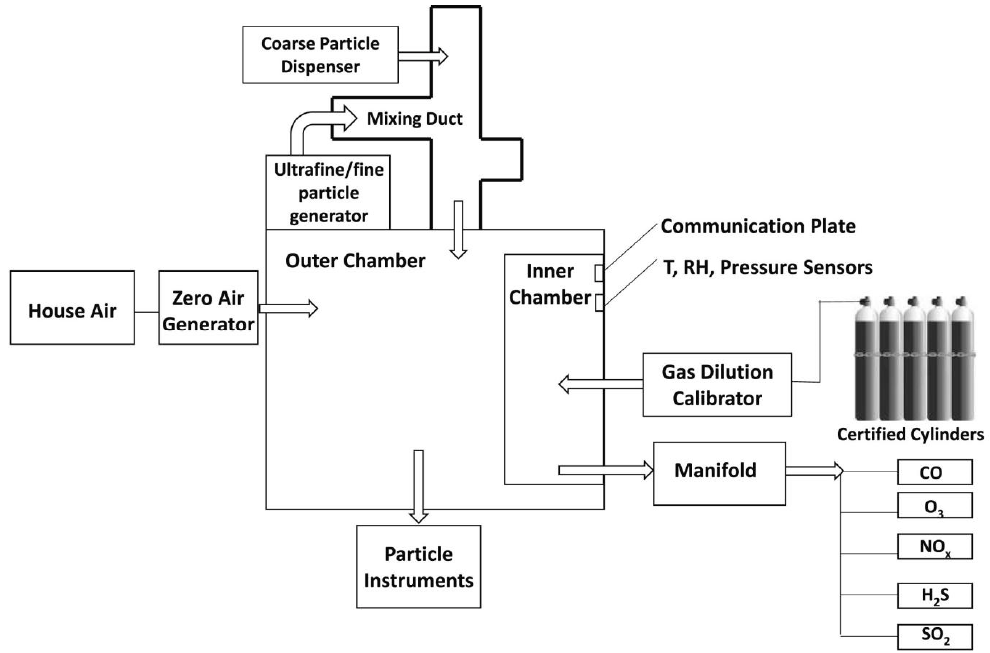
Figure 10. Schematic of the chamber system developed by Papapostolu et al. (2017) (image reprinted with ELSEVIER PERMISSION—License Number 4833500101157).